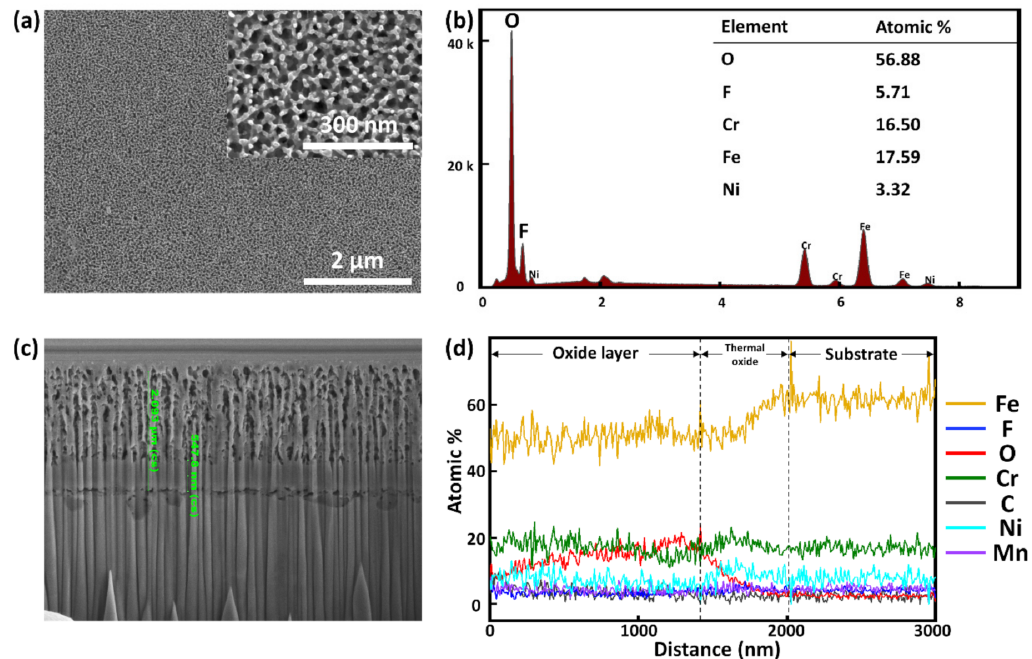
Figure 5. FESEM images showing surface morphologies of heat-treated anodized welded SS at low and high magnification ( a ) and EDX characterization of the surface ( b ). Cross-sectional FESEM image of anodized welded SS ( c ) and EDX line spectrum of the cross section ( d